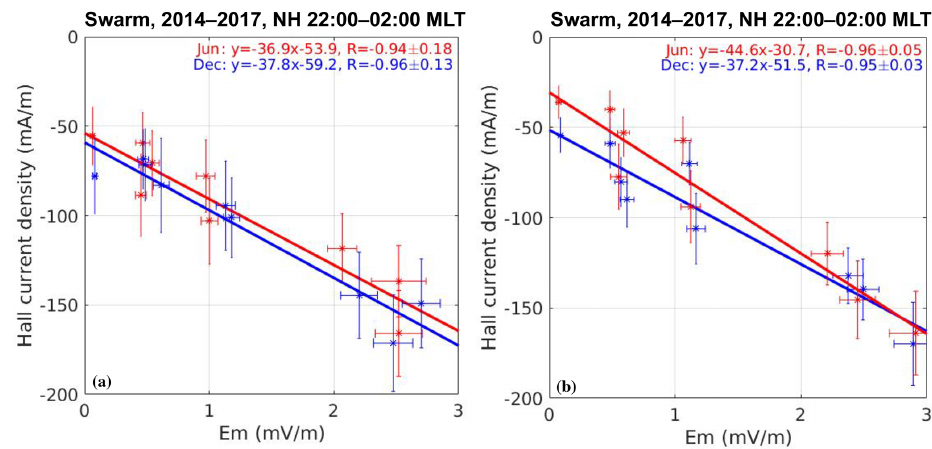
Figure 6. The relationship between E m and substorm electrojet in the midnight sector. The red (blue) line is used for June (December) solstice. Panels (a) and (b) represent the Northern and Southern hemispheres, respectively.